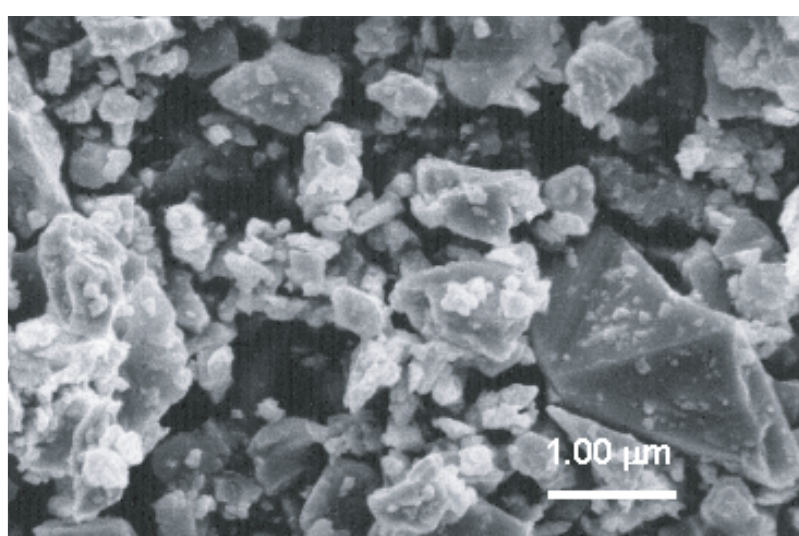
Figure 1 (above): SEM micrograph of hard- metal carbide powder.